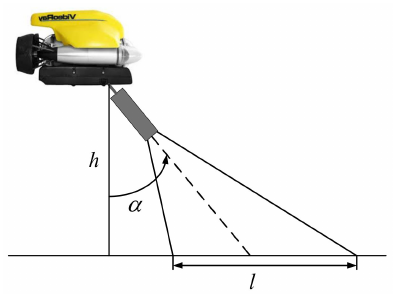
Figure 7. An underwater vehicle with cameras. Figure 8 shows the relation between the corresponding region of visibility and the distance from the bottom for different angles α . The other parameters are the following: baseline = 300 mm, focal length = 47.5 mm, velocity = 0.5 m/s, and acquisition rate =